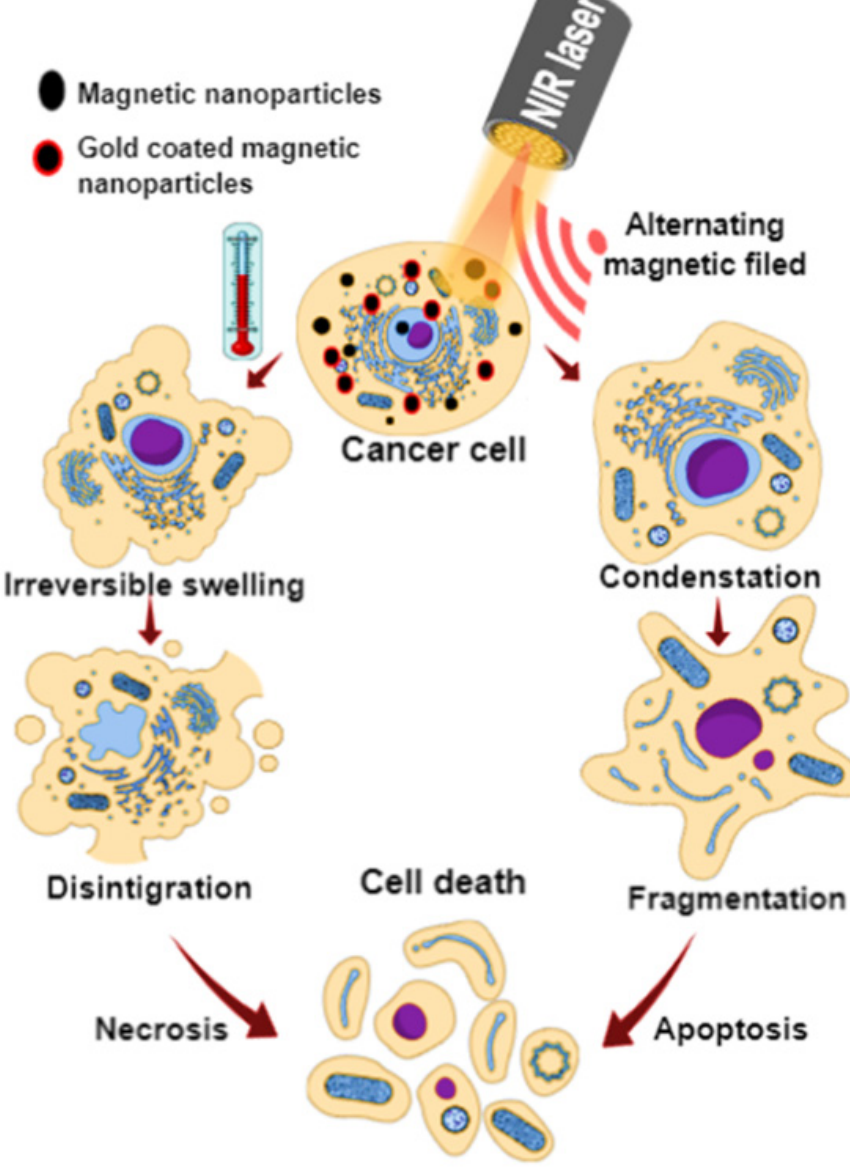
Figure 1. Magnetic nanoparticles or gold-coated magnetic nanoparticles induced by a near-infrared (NIR) laser or an alternating magnetic field (AMF) cause cancer cell death via apoptosis or necrosis by increasing the temperature.